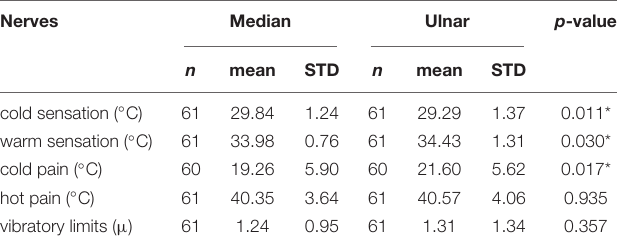
TABLE 2 | Mean quantitative sensory testing (QST) parameters in the median and ulnar